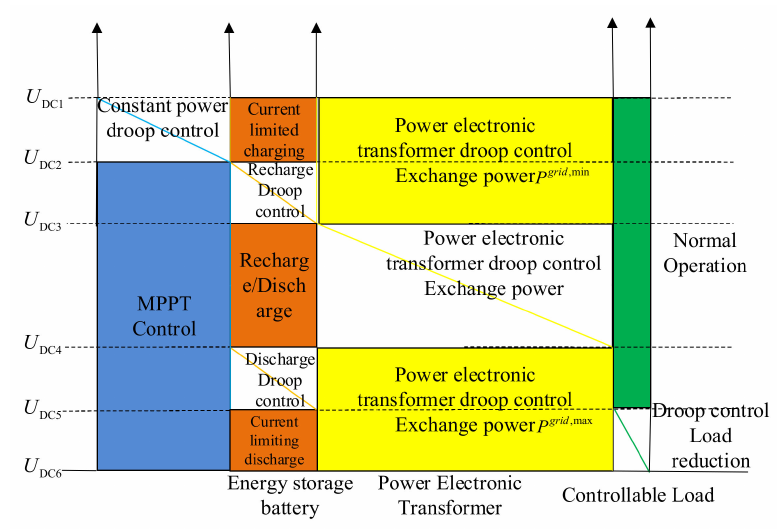
Figure 3. Operation control diagram of DC